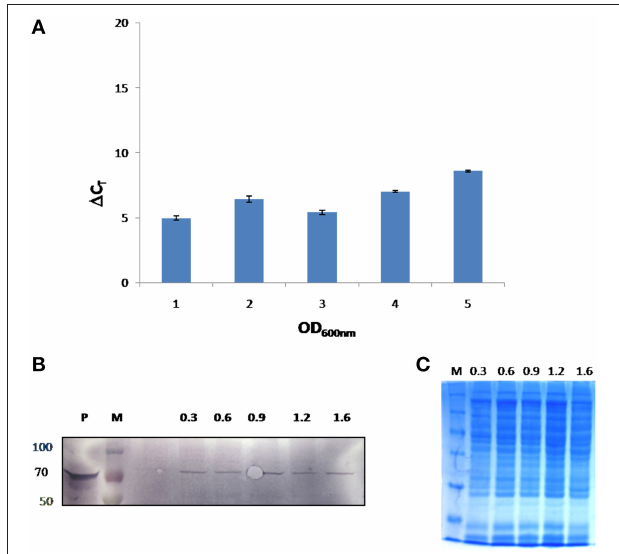
FIGURE 6 | In vivo expression of FlotP during different growth phases of B. anthracis. (A) RT-PCR was done for FlotP transcript using total RNA of various growth stages. Graph represents normalized Ct value with respect to different stages of growth. Data is a representative of three independent experiments showing similar trend. (B) Immunoblotting for in vivo FlotP expression in B. anthracis at different growth stages. Lanes: P- Purified rFlotP, M- marker, and rest indicate OD 600 i.e., 0.3, 0.6, 0.9, 1.2, 1.6 for different growth stages taken. (C) SDS page showing loaded protein for immunobloting of each OD 600